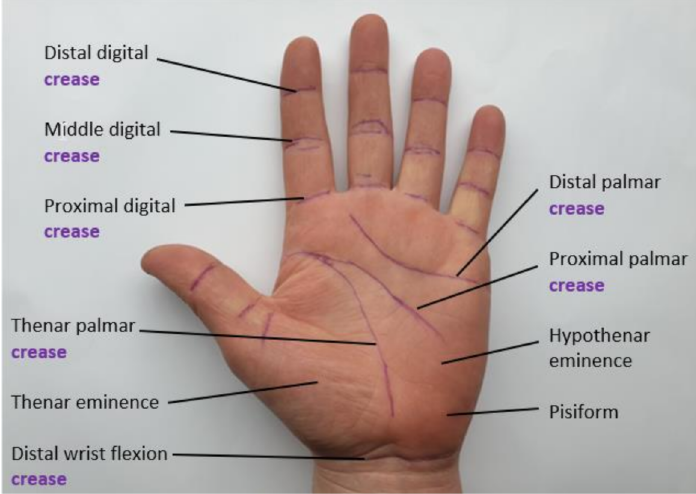
Figure 3. Landmarks of the palmar